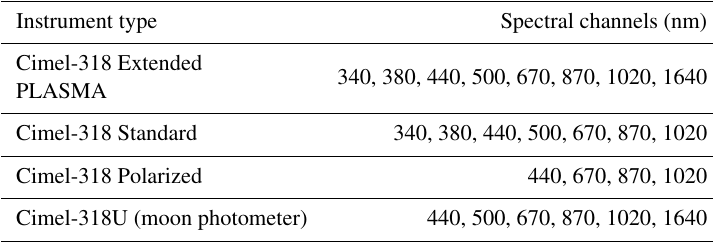
Table A1. Instrument wavelengths used in the GRASP-AOD inversion tests with real data (Sect.